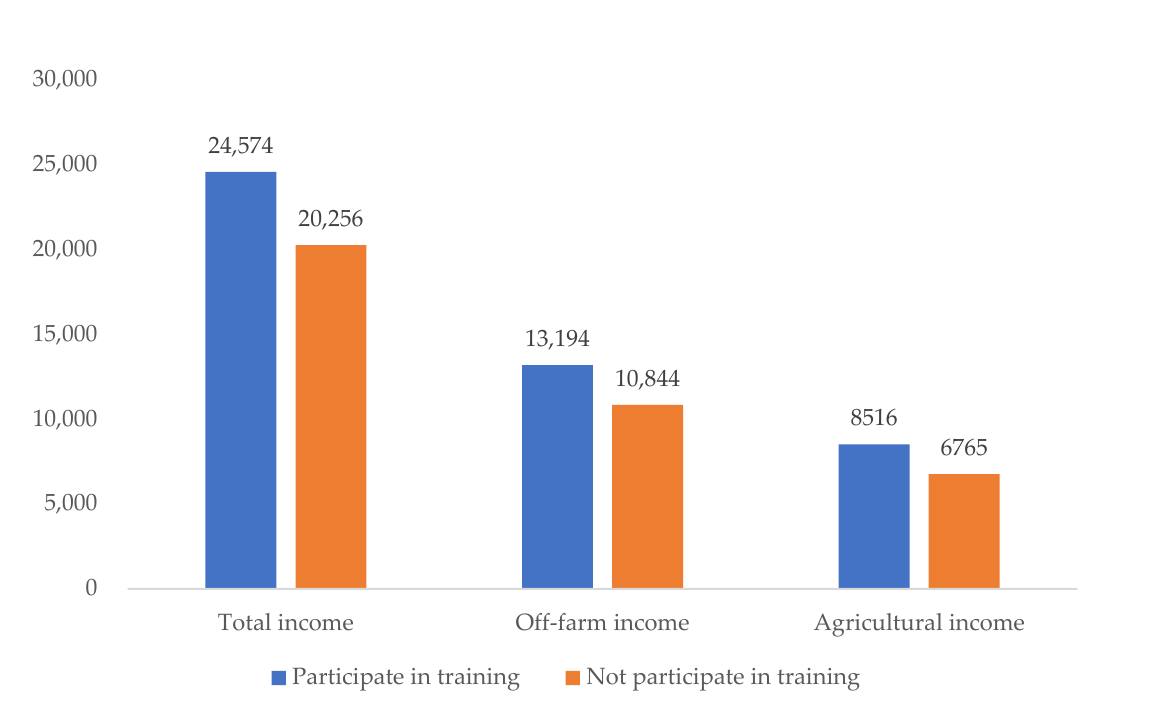
Figure 5. Income of households participating in skill training and not participating in skill training (CNY).